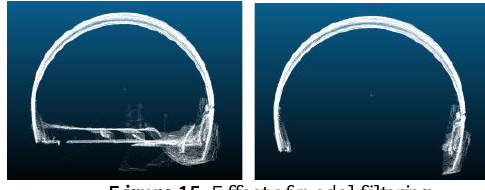
Figure 15 . Effect of model filtering